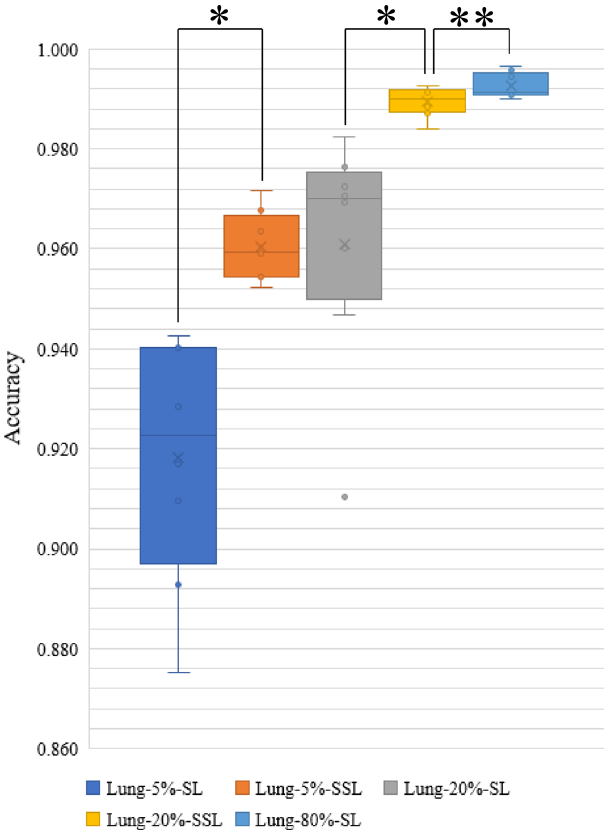
Fig. 5 Accuracy distribution of fi ve models on the testing set of LC25000 dataset (number of samples/patches per testing set = 3000; number of experiments per model = 8). The boxes indicate the upper and lower quartile values, and the whiskers indicate the minima and maxima values. The horizontal bar in the box indicates the median, while the cross indicates the mean. The circles represent data points, and the scatter dots indicate outliers. * indicates signi fi cant difference, and ** indicates no signi fi cant difference. The Wilcoxon-signed rank test (sample size/group = 8) is then used to evaluate the signi fi cant difference in the accuracy between two models. Two-sided P values are reported, and no adjustment is made. The average AUC and standard deviation (sample size = 8) are calculated for each model. Lung-5%-SSL vs. Lung-5%-SL: 0.960 ± 0.006 vs. 0.918 ± 0.023, P value = 0.012; Lung-20%-SSL vs. Lung-20%-SL: